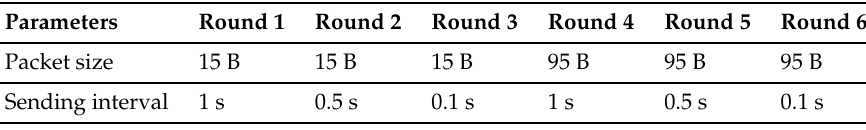
Table 6. Parameters used for each round of testing.